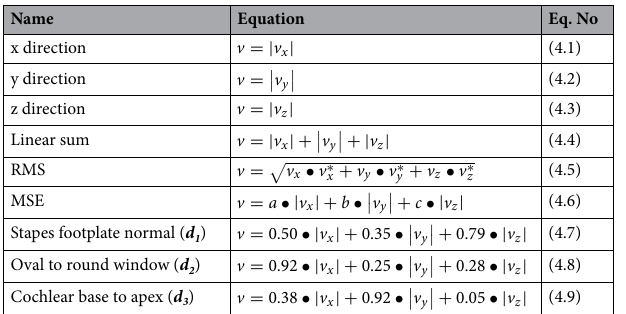
Table 2. Names and equations for the nine velocity functions used in the current analysis. * indicates complex